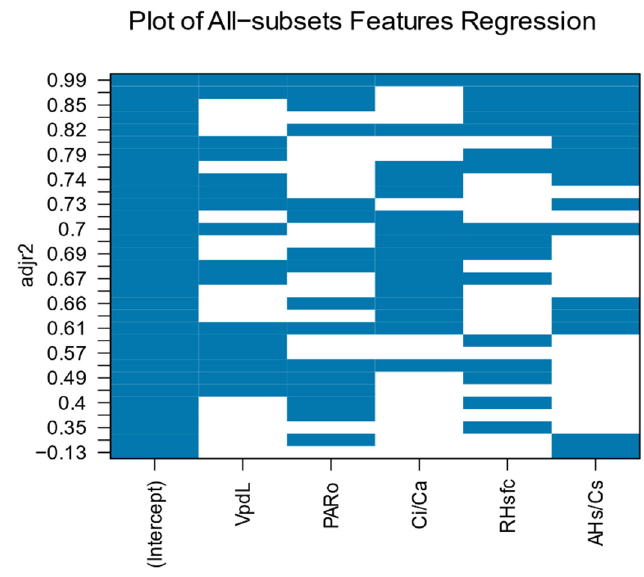
Figure 5. Results of the All-subsets regression.